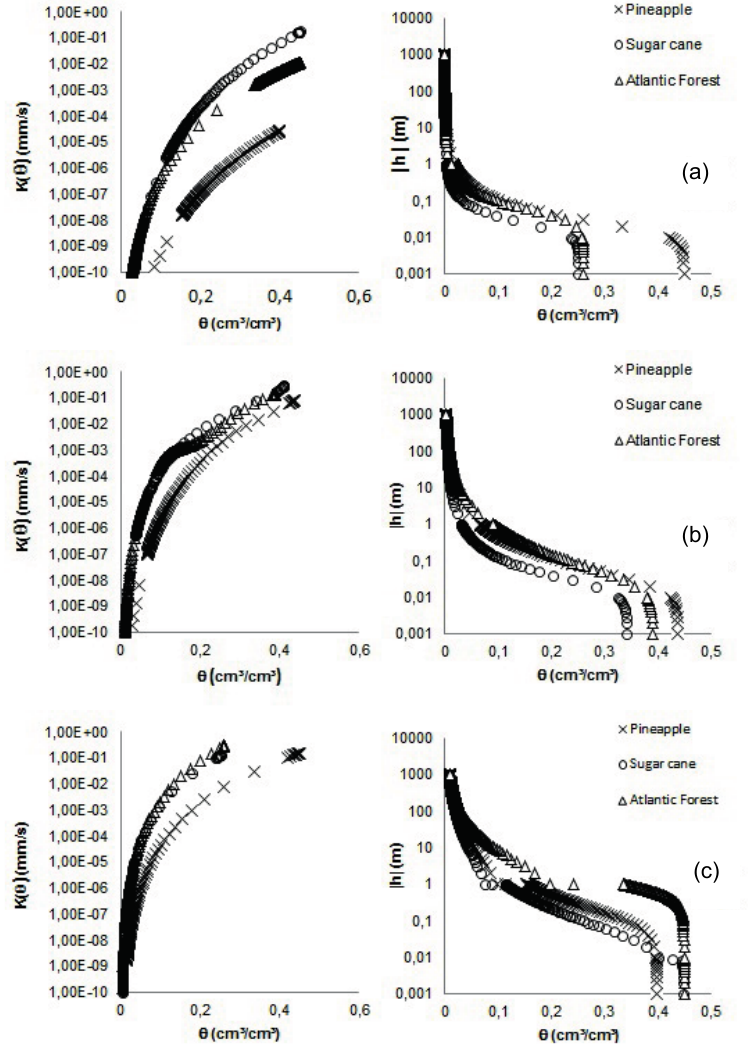
Fig. 4 Hydraulic conductivity curves and water retention curves (minimum (a), mean (b) and maximum (c)) according to the three land uses. The variation of saturated hydraulic conductivity values (Ks) is presented in Fig. 3, where mean, minimum and maximum values were plotted. The obtained values agree with Santos et al. (2012). For this parameter it is observed that the mean, maximum and minimum are higher